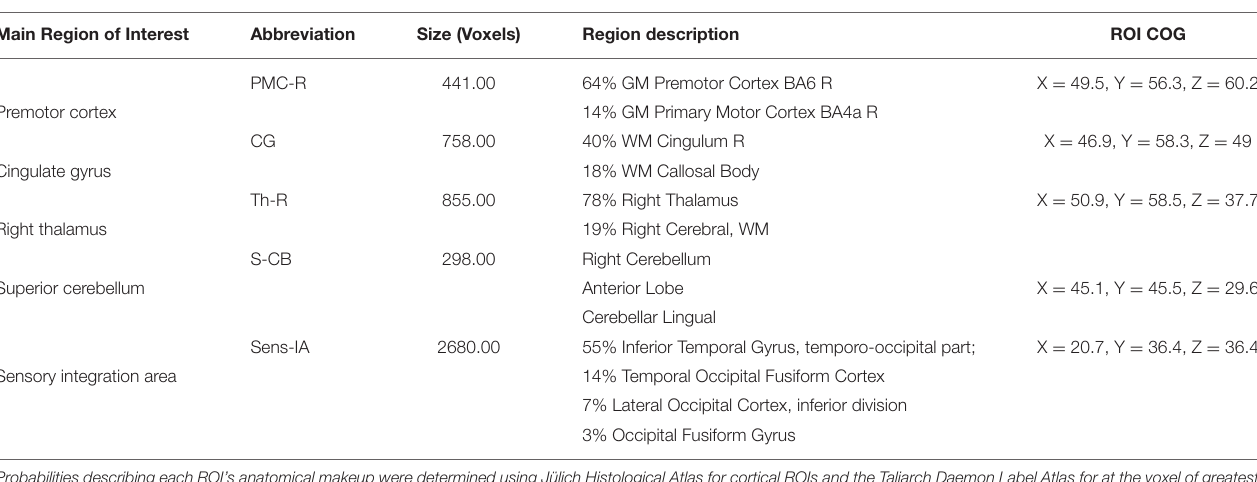
TABLE 4 | Activation ROI